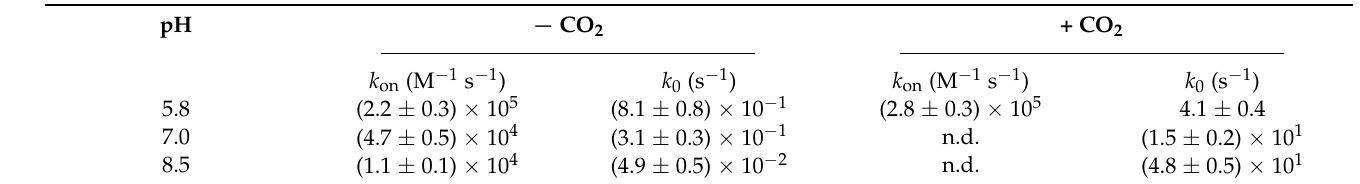
Table 1. Effect of pH and CO 2 on the values of k on and k 0 for Dr -Nb(III)-induced isomerization of peroxynitrite at 22.0 ◦ C a .